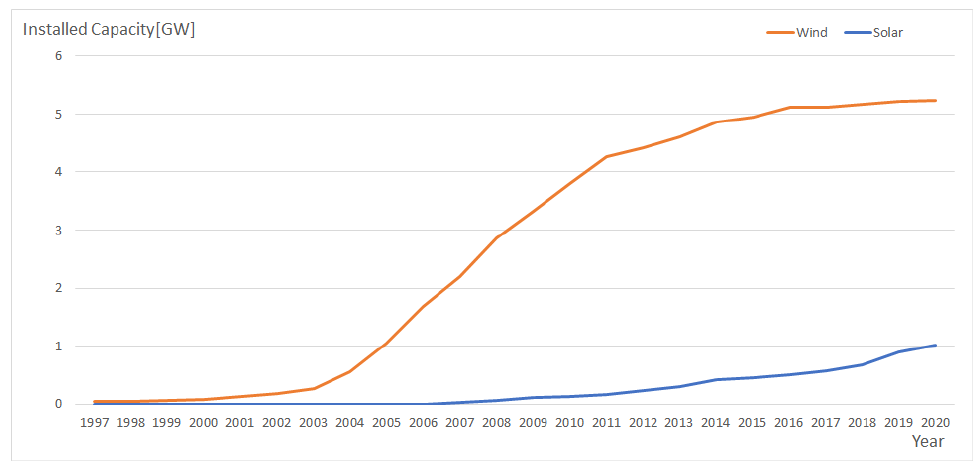
Figure 3. Wind and solar installed capacity in Portugal. Adapted from [70,71].